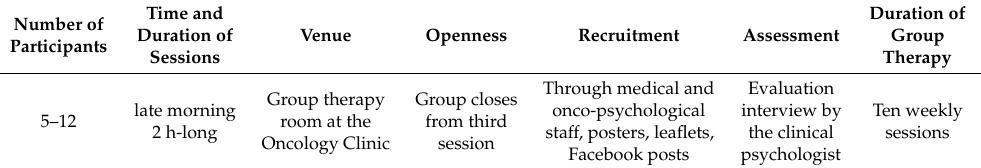
Table 1. Initial considerations for group